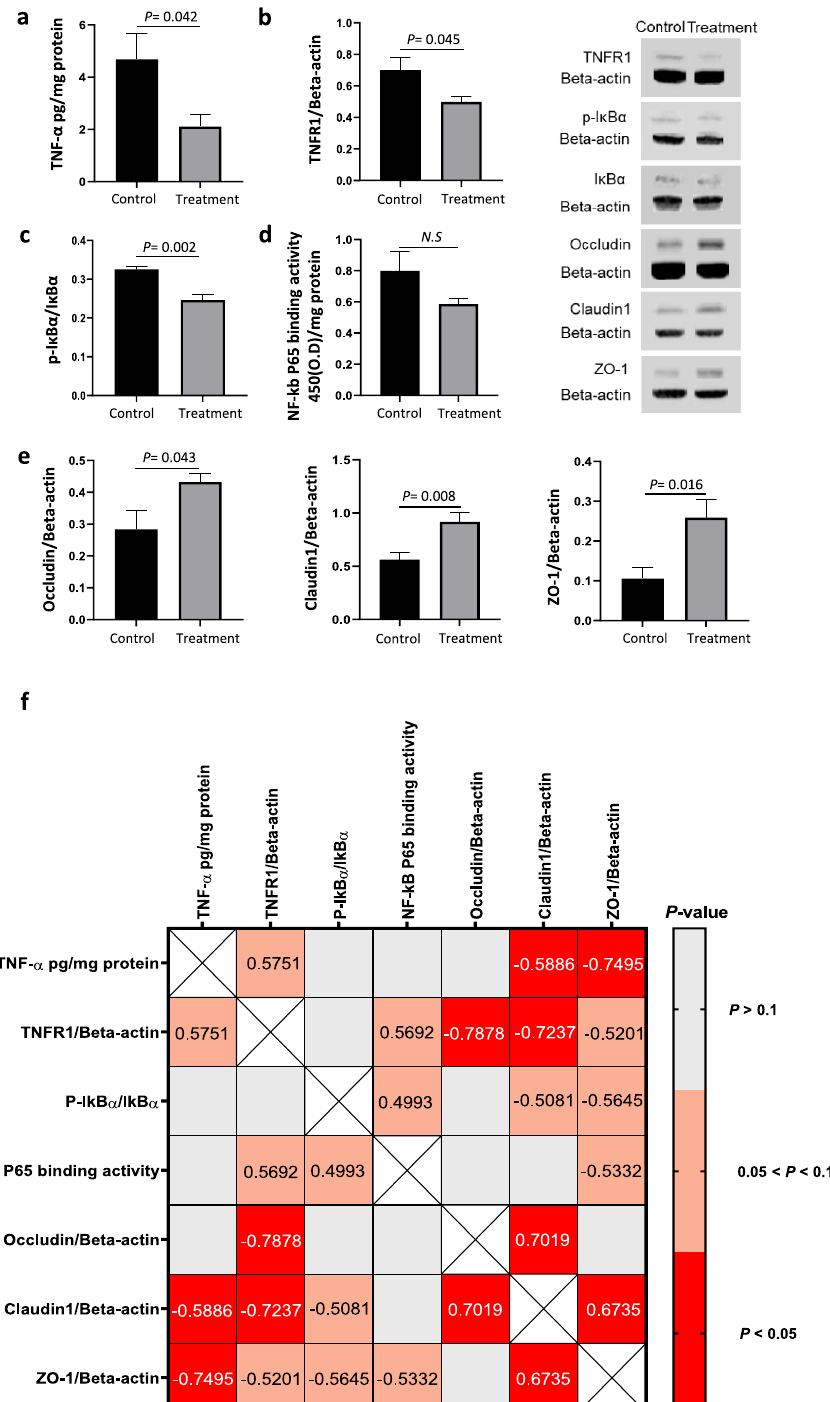
Figure 1. Tan IIA-NP + iNSC treatment reduced inflammation and improved expression of tight junction proteins in jejunal mucosa at 12 weeks post-treatment. At 12 weeks PT, treated pigs showed decreased protein levels of ( a ) TNF-α, ( b ) TNFR1, ( c ) phosphorylation of IkBα relative to the control. ( d ) Treatment decreased binding activity of NF-kB P65 compared to control although not statistically significant. ( e ) Treatment significantly increased protein expression of gut tight junction proteins occludin, claudin1, and ZO-1 compared to control. Unpaired t-test N = 6 each group. ( f ) Protein levels of TNF-α, TNFR1, phosphorylated IkBα, and binding activity of NF-kB P65 were correlated with the expression of gut tight junction proteins occludin, claudin1, and ZO-1. Significant correlations ( P value < 0.05) are highlighted in red while trending correlations are represented in orange. The number inside each box represents the r-value, r = Pearson correlation